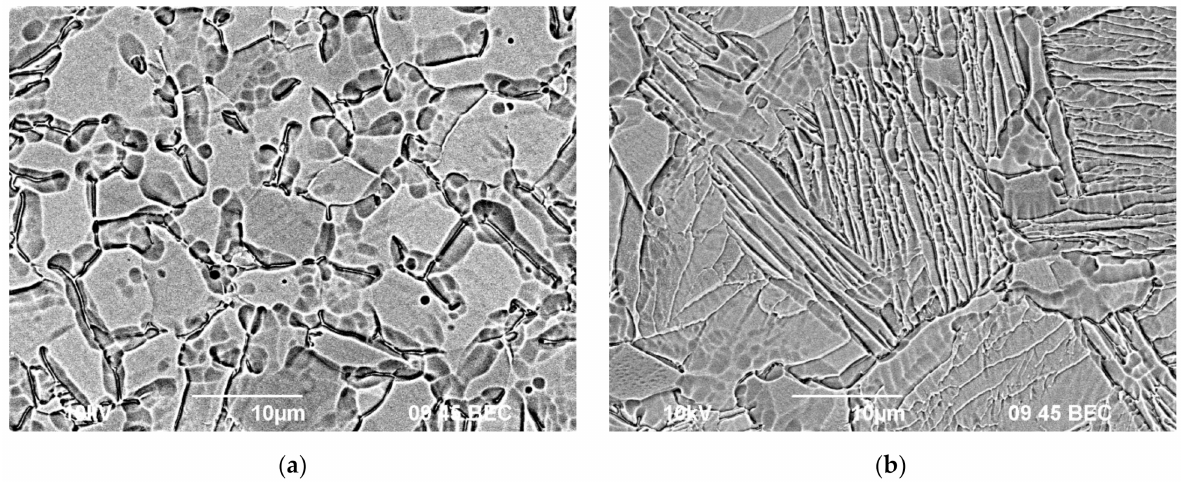
Figure 3. Microstructure of the grain boundaries with β -phase particles in the Ti5Al2V ( a ) and Ti6Al4V ( b ) titanium alloys. SEM (BEC